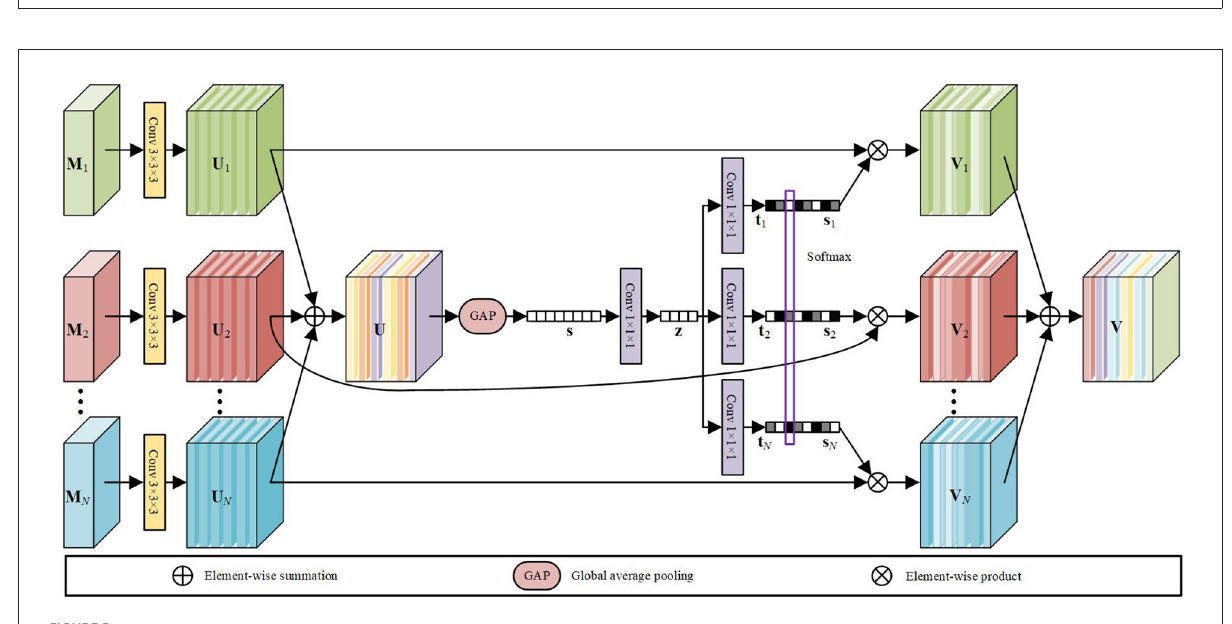
FIGURE5 The architecture of our MSFF module for multimodal feature